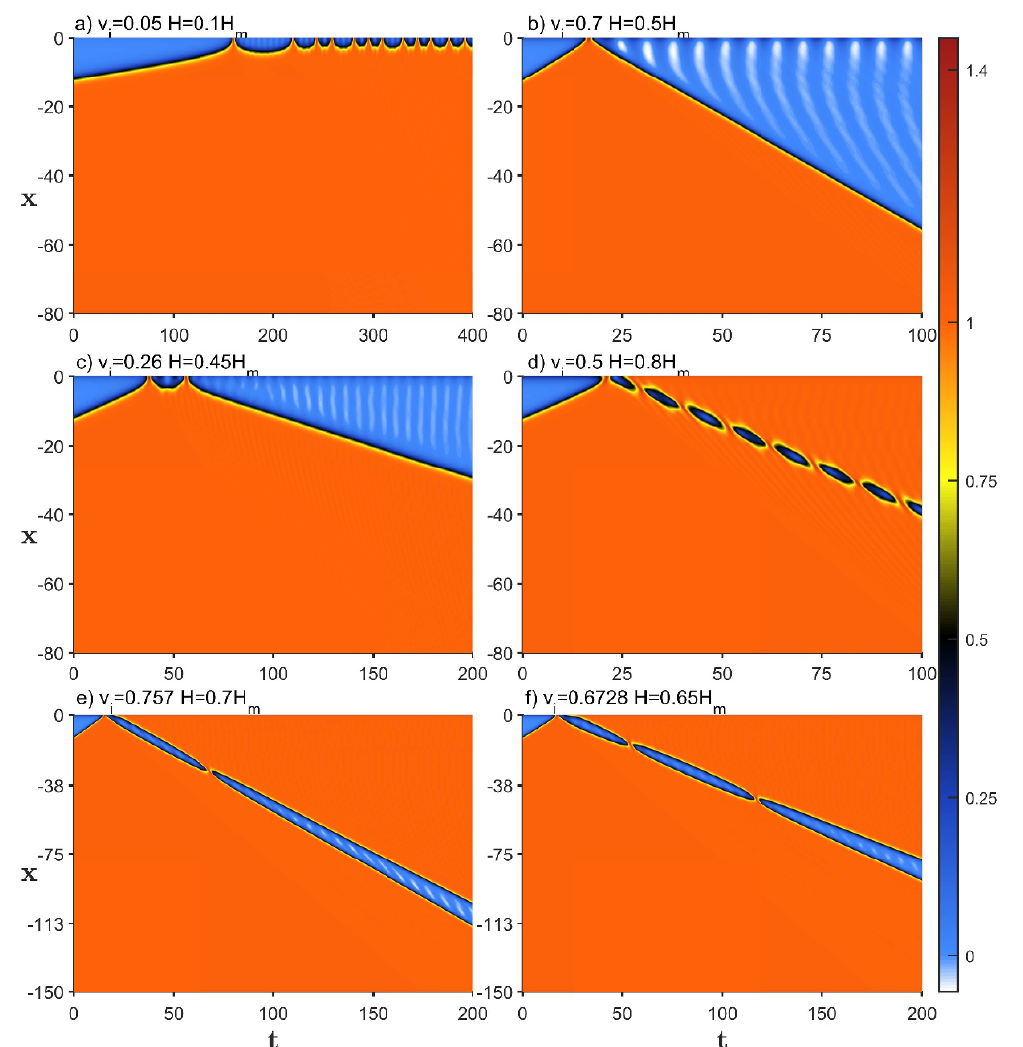
Figure 10 . Φ 2+ ( x ) antikink scattering with φ 1 boundary, showing a) bion state at the boundary, b) inelastic scattering (one-bounce) with the boundary, c) two-bounce collision with the boundary, d) production of a Φ 1+ ( x ) kink from the boundary, forming a composed oscillating state, e) production of a Φ 1+ ( x ) kink from the boundary, showing the antikink colliding once with the formed kink, f) production of a Φ 1+ ( x ) kink from the boundary, showing the antikink colliding twice with the formed kink. One can localize the structure of the output field profile at the boundary in the next figure 11.